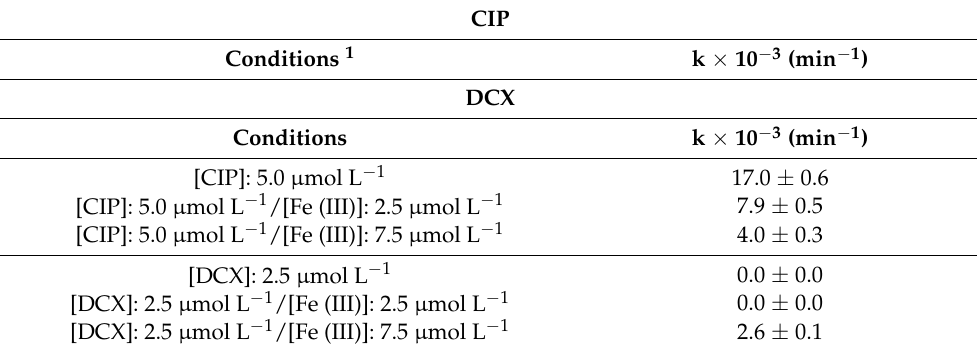
Table 3. Effect of iron concentration on the degradation of ciprofloxacin (CIP) and dicloxacillin